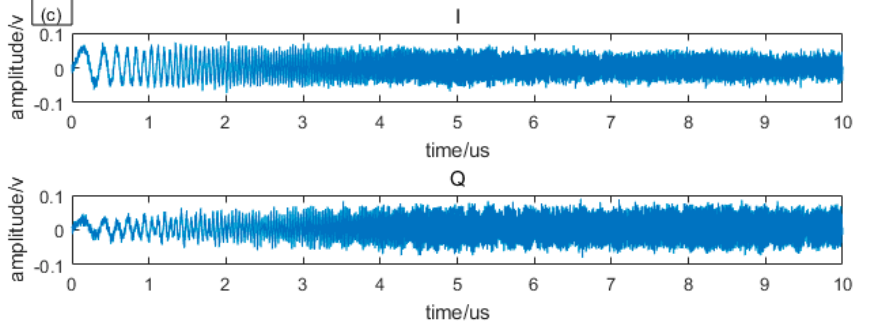
Figure 3. Three cases of detected RF echo are listed as: ( a ) I is strong while Q is weak; ( b ) I is weak while Q is strong. ( c ) I and Q are almost equal.